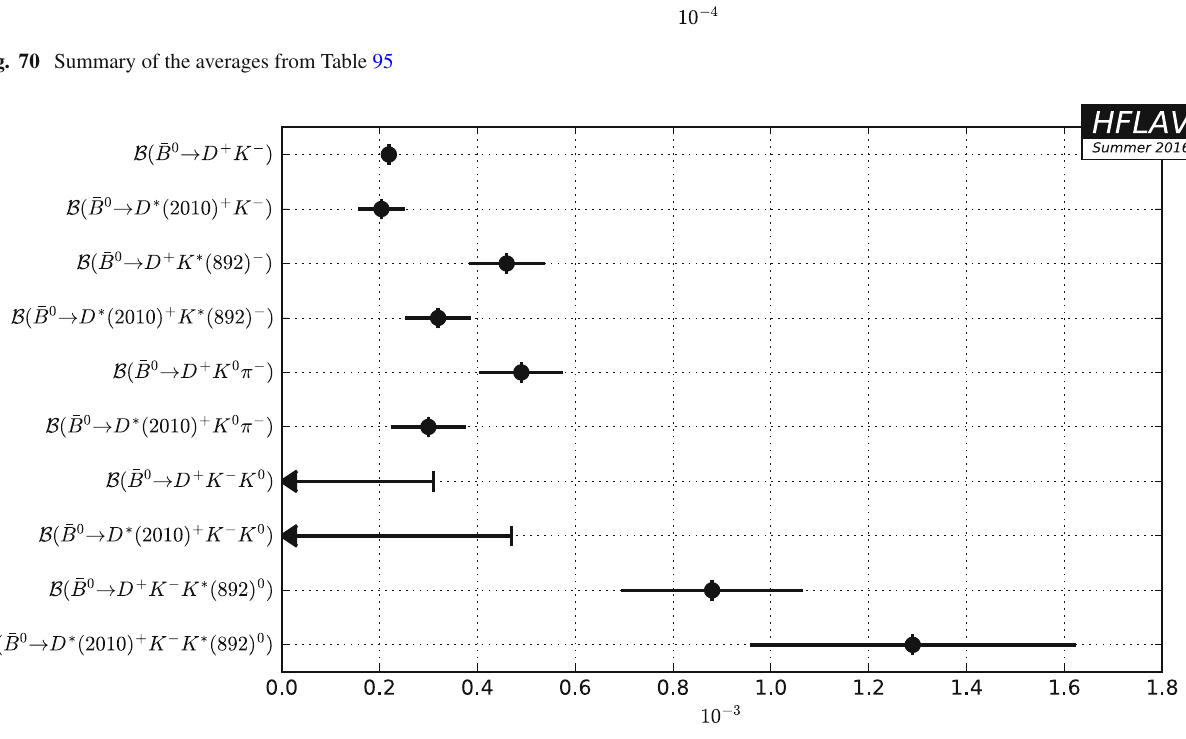
Fig. 71 Summary of the averages from Table